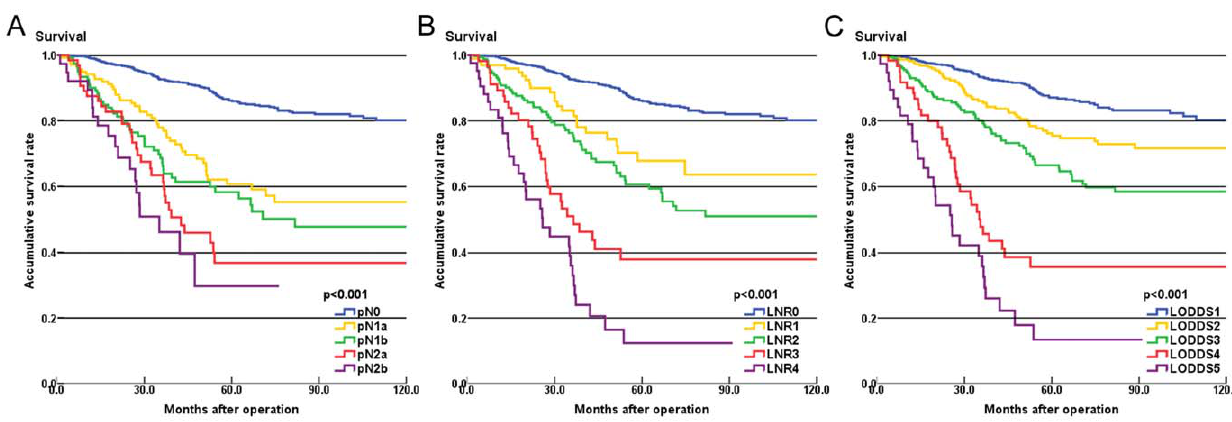
Figure 1. Survival curves of colorectal cancer patients according to three classifications (pN, LNR, LODDS) are depicted.